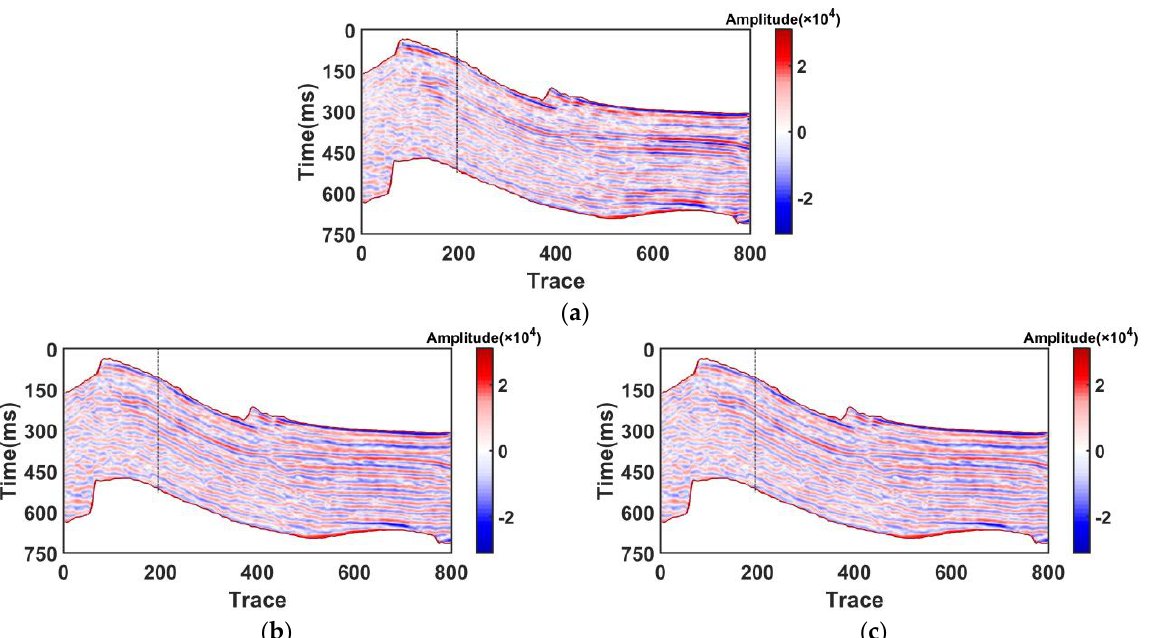
Figure 27. Stacked data volume with different incident angles: (a) 9°; (b) 18°; (c) 20°.